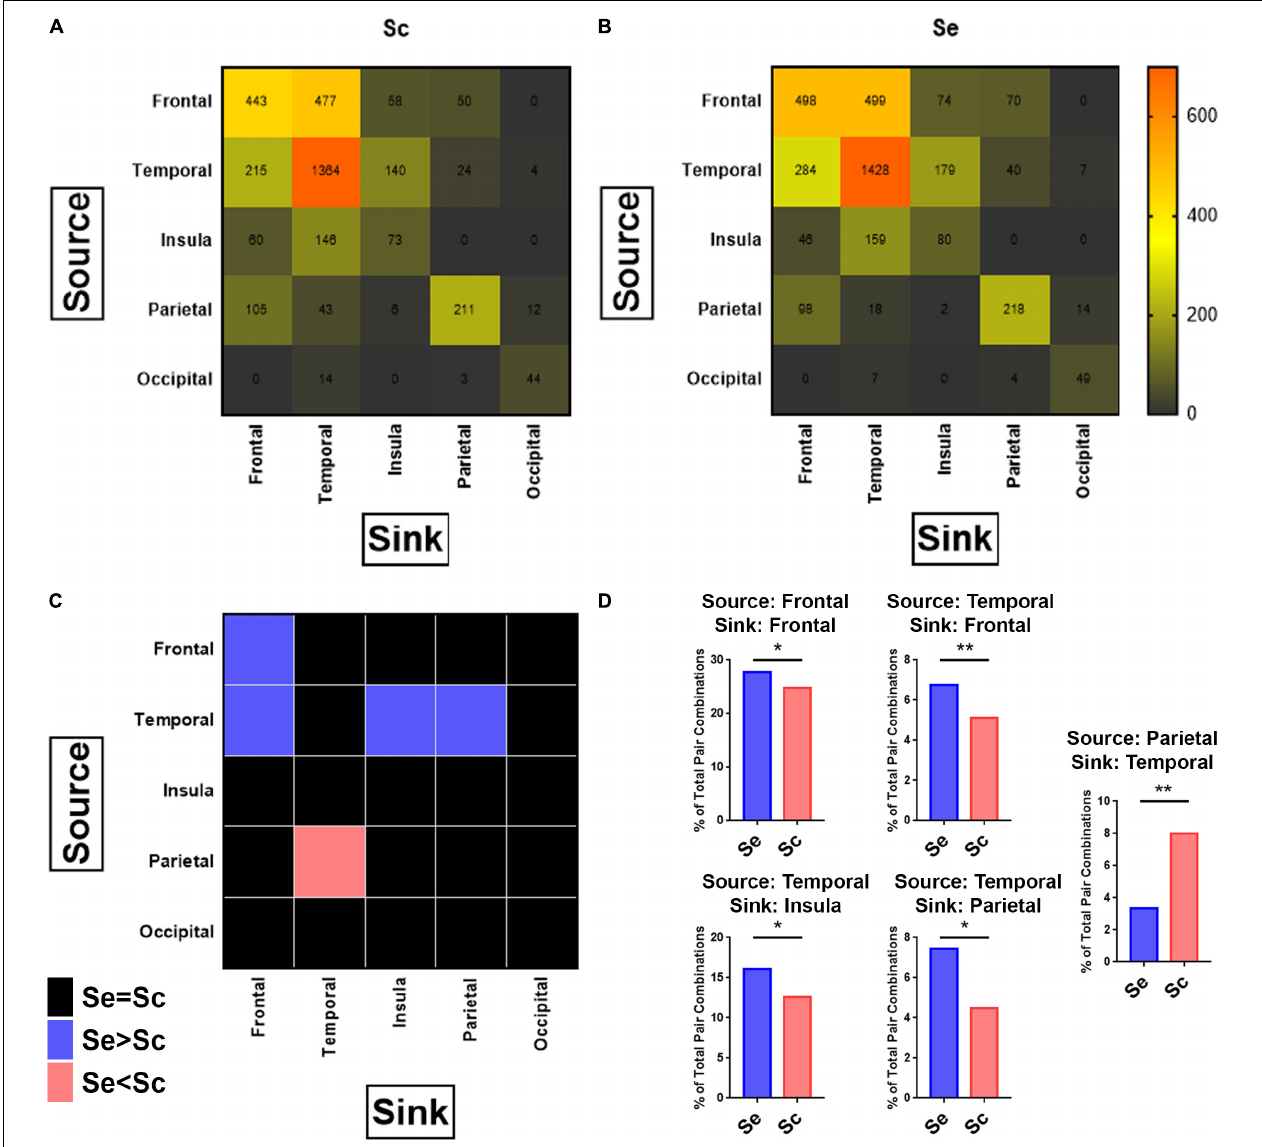
FIGURE 7 | Connectivity between brain regions in response to sequential and scrambled patterns. For each combination of possible pairs of recording sites per subject, granger causality was applied to calculate the connectivity between the studied pairs along the first 100–500 ms after the onset of the images corresponding to sequential and scrambled patterns independently (see section “Materials and Methods”). (A, B) Heatmap of the number of pairs with high connectivity between sources (each row represents one source brain region), and sinks (each column represents one sink brain region) for scrambled (A) , and sequential (B) patterns. Chi-Square test for comparing the distribution of high connectivity regions between Scr vs. Seq shows a significant difference in the distribution. Pearson’s Chi-Square: 193.1, P < 0.001. (C) Heatmap of p -values after applying the Chi-Square test to determine which source-sink brain regions exhibit significant differences in the number of connections between sequential and scrambled patterns. In pink are the source-sink cells that has Seq < Scr whereas in blue are source-sink cells with Seq > Scr for P < 0.05. The nonsignificant differences are colored black. (D) Re-demonstration of findings from (C) showing that sequential patterns has a significantly higher percentage of connectivity pairs compared to scrambled patterns when the (source, sink) combinations are: (Frontal, Frontal), (Temporal, Frontal), (Temporal, Insula), (Temporal, Parietal), and scrambled patterns has a higher percentage of connectivity pairs compared to sequential patterns when the (source, sink) combination is (Parietal, Temporal). Chi-Square test. P -value adjusted for multiple comparisons based on adjusted residuals: * P < 0.05, ** P < 0.01. See also Supplementary Figure 6